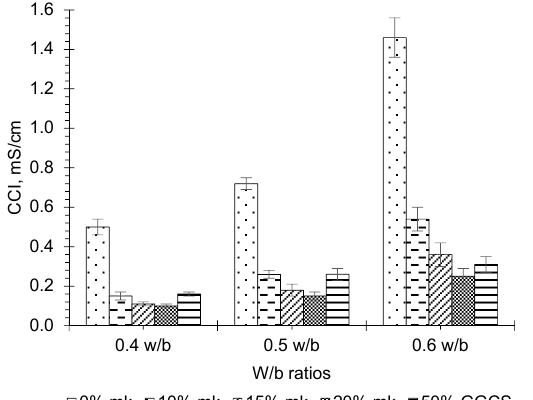
Figure 6 . Chloride conductivity index (CCI) values of concrete at different w/b ratio.